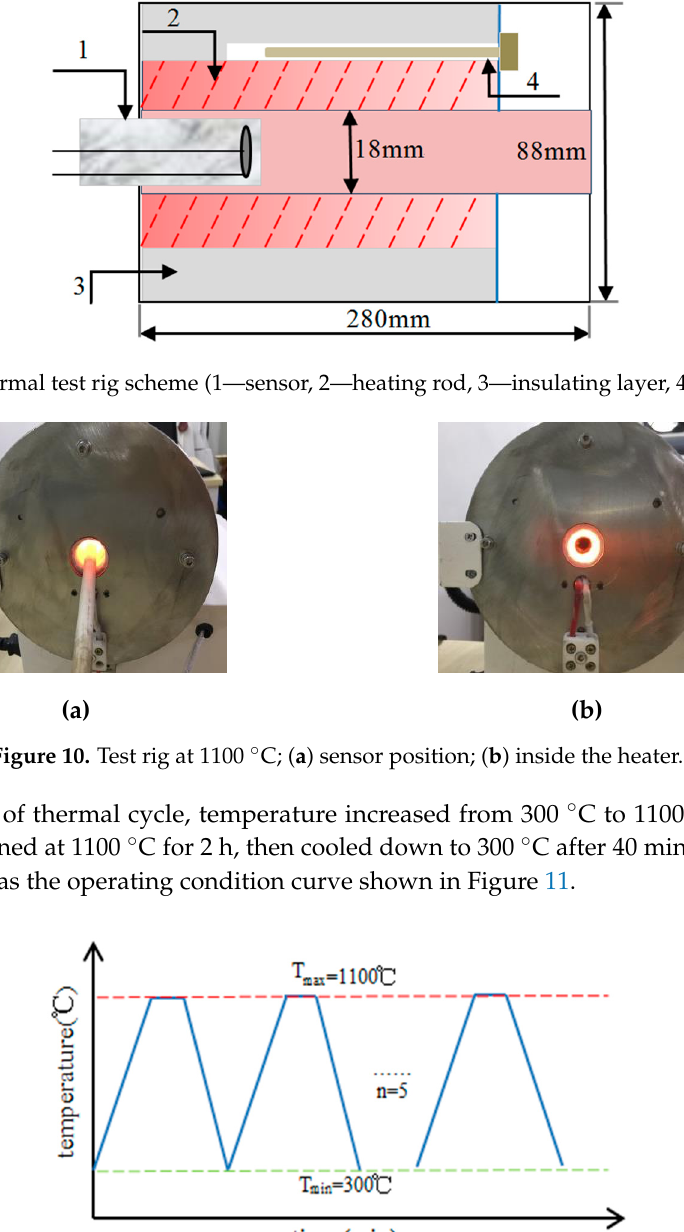
Figure 11. Temperature cycling curve.